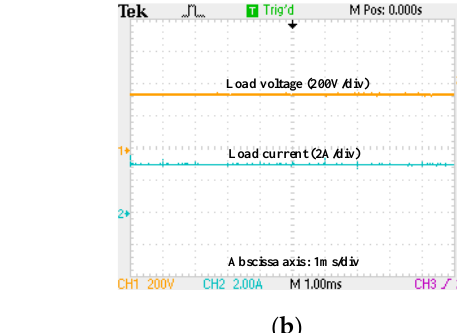
Figure 15. Output voltage and output current of the proposed rectifier. ( a ) Simulation result. ( b ) Experimental result.